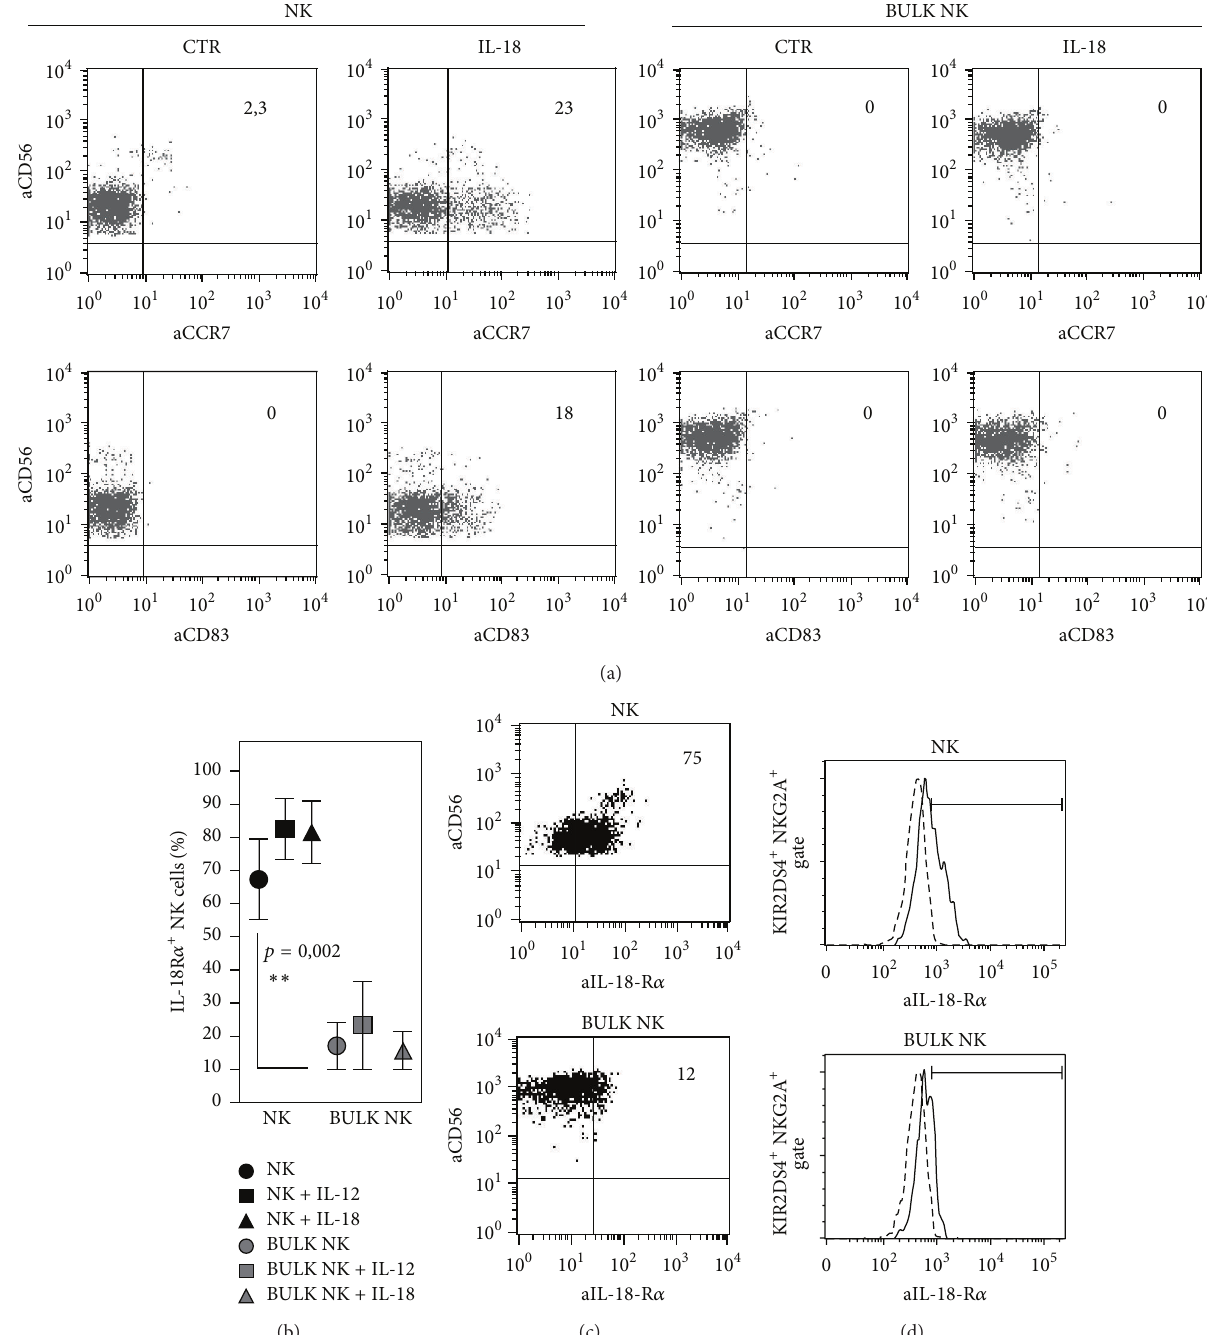
Figure 2: Analysis of the IL-18R 𝛼 surface expression on resting or activated NK cells: functional implications. (a) Freshly isolated (NK) and IL-2 activated (BULK) NK cells from one B haplotype donor were cultured in the presence of exogenous IL-18 for 18 hours and then analyzed for CCR7 expression. Analysis of CD83 expression on NK cells was used as a positive control of the effect mediated by IL-18. The values reported in the upper-right corners indicate the percentage of CD56 + CCR7 + or of CD56 + CD83 + NK cells. A representative of 10 independent experiments performed using different donors is shown. (b) Freshly isolated or short-term (18h) activated NK cells (NK) from one B haplotype donor were analyzed for the expression of IL-18R 𝛼 in comparison with long-term IL-2 activated (BULK) NK cells form the same donor. BULK NK cells were also treated for 18h with either IL-18 or IL-12, after washing the cells, to remove IL-2 from the supernatant and then analyzed for the expression of IL-18R 𝛼 . The average of 6 independent experiments and standard deviation (mean ± SD) are indicated. ∗∗ 𝑝 < 0.01 . (c) A representative B haplotype donor is shown for the expression of IL-18R 𝛼 on both resting and BULK NK cells. (d) The histogram plots refer to the expression of IL-18R 𝛼 on both resting and BULK NK cells of a representative B haplotype donor after gating on KIR2DS4 + NK cells. The dashed line represents the isotype